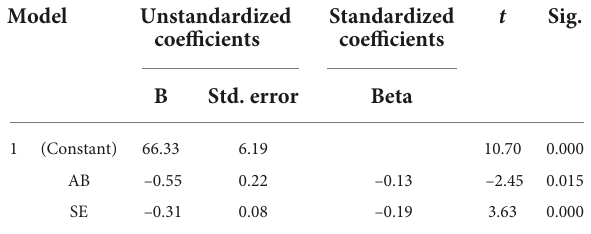
TABLE 6 Coefficients for teachers’ self-efficacy, academic buoyancy, and burnout.